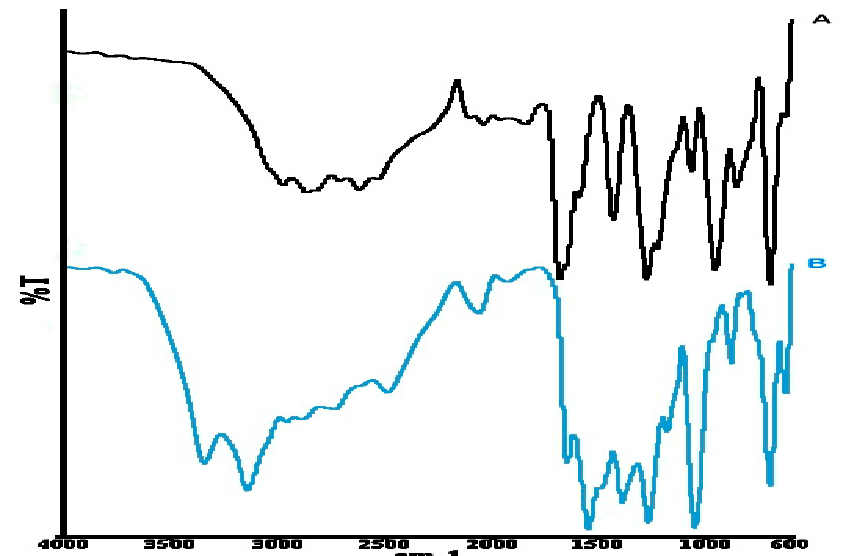
Figure 4. FT–IR spectra of ( A ) ketoprofen and ( B ) the multicomponent crystal phase of ketoprofen and tromethamine.